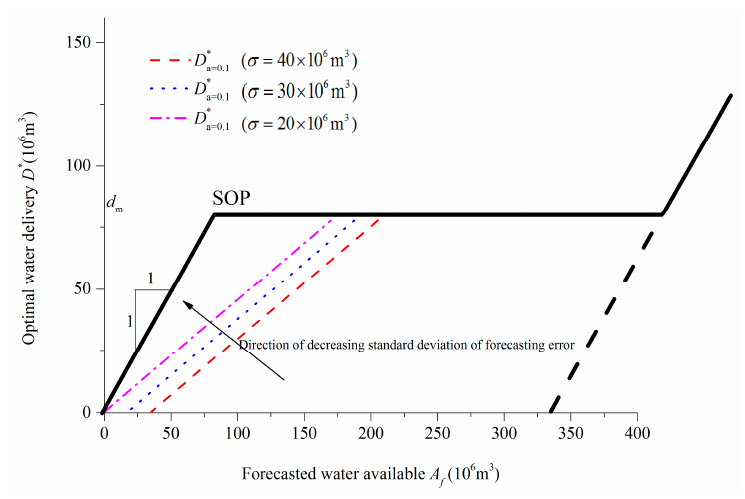
Figure 4. Optimal hedging policies under different values of σ ( α = 0.1).